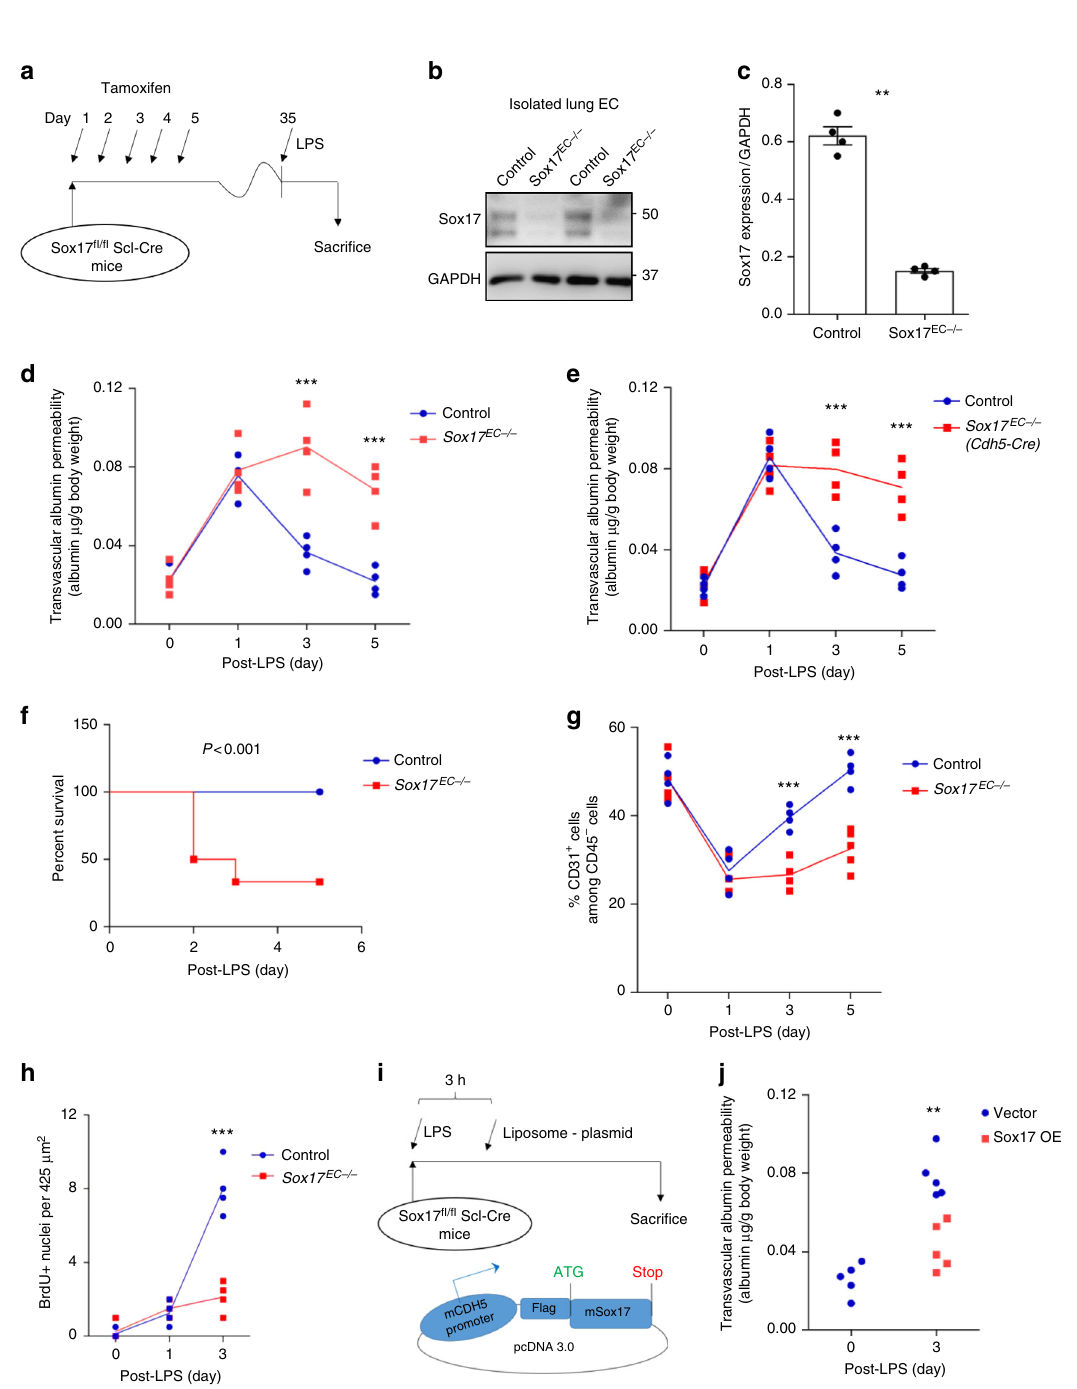
Fig. 2 Activation of Sox17 at onset of EC regeneration and Sox17-mediated Cyclin E1 expression. a qPCR analysis of gene expression in sorted CD31 + cells from mTmG- Scl mice before and after injury (12 mg/kg i.p.). Sox17 , Vegfr2 , and Ccne1 increased signi fi cantly at day 2 post-LPS compared to baseline. n = 3. Color scale: the fold change increases from red to white to green color. b Western blot analysis in fresh isolated ECs from wild-type mice and quanti fi cation c showed a 5-fold increase in Sox17 protein expression within 1 day following injury compared to baseline and followed by recovery within 3 days post-LPS. n = 3. d , e Western blot analysis of cultured HLMVECs in which Sox17 was overexpressed showed 2.5x fold increase in Cyclin E1 protein expression relative to control cells. n = 3. OE, overexpression. f Representation of the CCNE1 promoter region with Sox17 binding sites (circled numbers) and their sequences. g HLMVECs were retrovirally transduced with Sox17 or control plasmid for 3 days, and Ch-IP assay followed by qPCR was performed to amplify Sox17 binding sites in the CCNE1 promoter. n = 3. h 293T cells were transfected with a Sox17 overexpression plasmid containing CCNE1 luciferase reporter constructs. Luciferase values were normalized to Renilla luciferase control reporter values. A schematic representation of corresponding deletion constructs is presented in the right panel. n = 3 and duplicates per sample. ** P < 0.01 and *** P < 0.001. Data are shown as mean ± SEM. Analysis